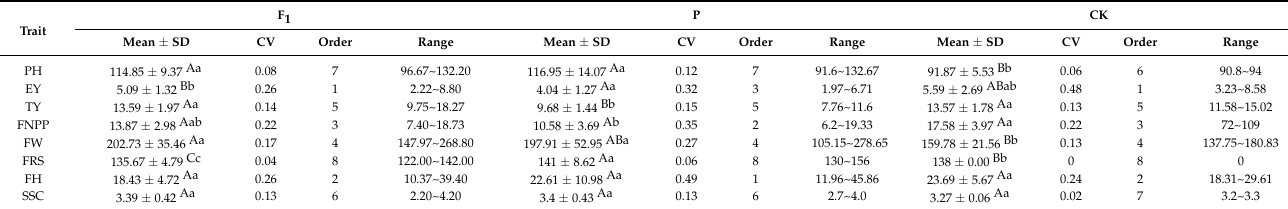
Table 2. The expression and coefficients of variation in 10 parents, 45 F 1 hybrids, and control (CK) for eight main agronomic traits.